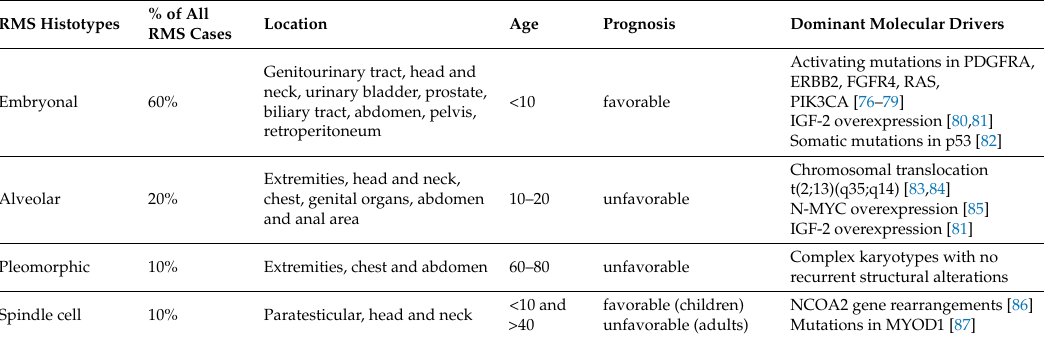
Table 2. Histological classification and molecular drivers of rhabdomyosarcom